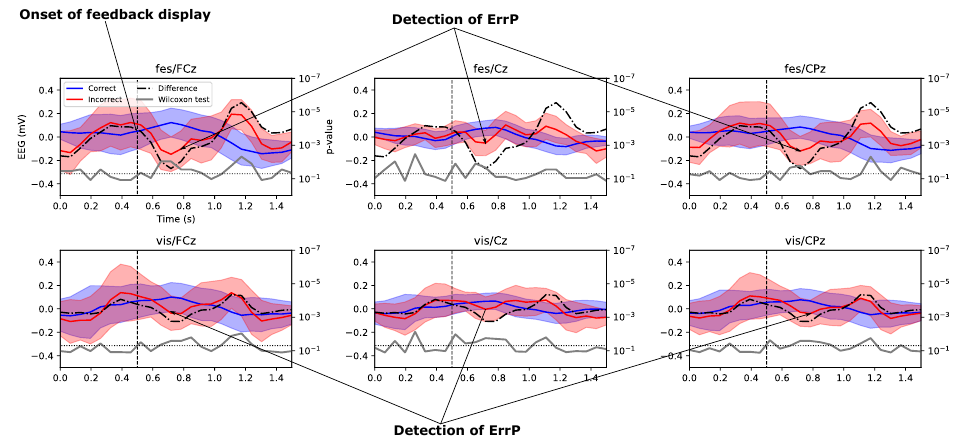
Figure 5. Grand averages of the event-related potentials at electrodes FCz, Cz, and CPz during correct (in blue) and incorrect (in red) feedback received while the participants in the FES ( top panel ) and VIS ( bottom panel ) groups were conducting the motor imagery tasks. The differences between the correct and incorrect ERP signals are plotted in black, and the corresponding p -values of the Kruskal–Wallis test [62] at each time instance are compared between the correct and incorrect feedback trials. The black-dotted horizontal line represents the 5% significance level, and the dotted vertical line represents the onset of a feedback display (both visual and somato-sensory) received by the